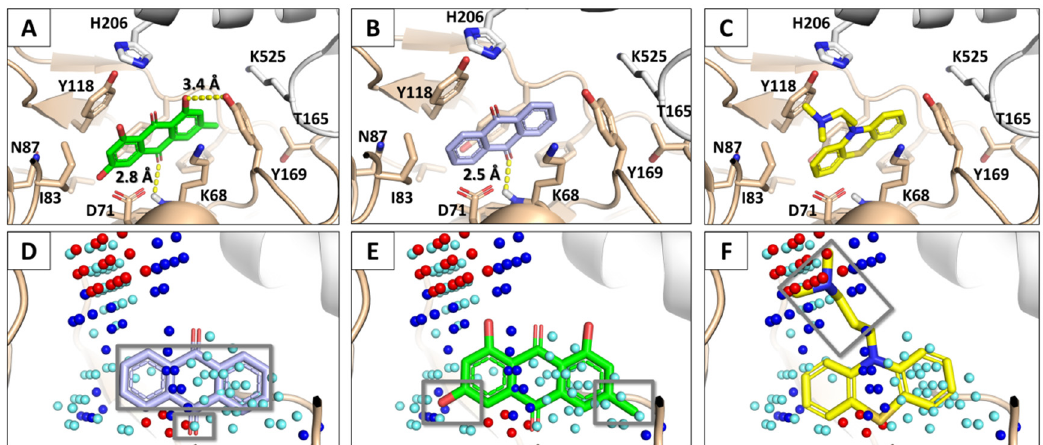
Figure 3. Binding poses of emodin, anthraquinone and promazine. Ligands and surrounding residues are represented in sticks. Yellow dotted lines indicate polar contacts. SARS-CoV-1 S protein is colored in yellow, while ACE2 is colored in white. Cyan, red and blue spheres indicate regions sterically and energetically able to receive hydrophobic, hydrogen bond acceptors and hydrogen bond donor groups respectively. ( A ) Binding pose of emodin. ( B ) Binding pose of anthraquinone. ( C ) Binding pose of promazine. ( D ) Binding pose of anthraquinone and the pharmacophoric fingerprint of pocket. Grey boxes indicate the pharmacophoric matches. ( E ) Binding pose of emodin and pharmacophoric fingerprint of pocket. Grey boxes indicate the additional pharmacophoric matches compared to anthraquinone. ( F ) Binding pose of promazine and the pharmacophoric fingerprint of pocket. Grey box indicates the additional pharmacophoric matches due to the branched amino